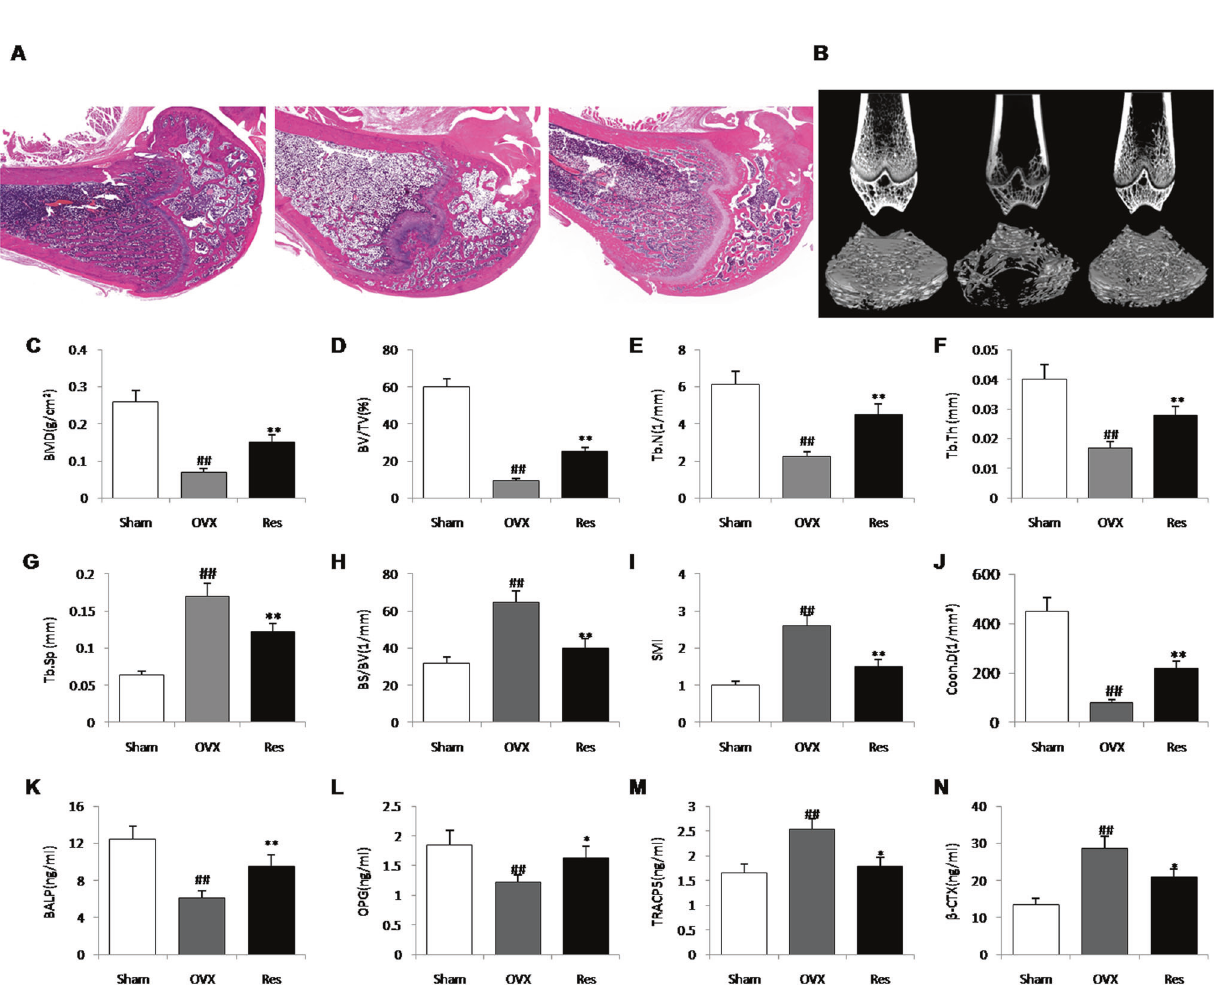
Fig. 5 Protective effect of resveratrol on osteoporosis in ovariectomized rats. A The hematoxylin-eosin staining in distal femur among groups. B The 2D images of sagittal and transverse section. C – J The trabecula parameters of cancellous bone in the proximal tibial metaphysis static parameters: BMD bone mineral density, BV/TV bone volume/tissue volume, Tb.N trabecular number, Tb.Th trabecular thickness, Tb.Sp trabecular separation, BS/BV Bone surface/bone volume, SMI structure model index, and Conn.D connectivity Density. K – N serum bone alkaline phosphatase (BALP), osteoprotegerin (OPG), tartrate resistant acid phosphatase (TRACP-5b), and β -cross-linked c-telopeptide of type I collagen ( β -CTX), n = 5, ## P < 0.01 vs. Sham group; * P < 0.05 vs. OVX group and ** P < 0.01 vs. OVX group. Effects of resveratrol on osteocytes redox balancein in bones (Fig. 5B-J). In addition, serum levels of BALP and osteocalcin, ovariectomized rats bone formation markers, and Tracp 5b and β -CTX, bone resorption To determine whether postmenopausal prevention of resveratrol markers, were detected for assessing the turnover of the bones. is related to a low oxidative stress of osteocytes, the activity and BALP and osteocalcin levels were lower, but β -CTX and TRACP-5b expression of antioxidant enzymes and ROS were examined in levels were obviously higher in the OVX rats than those in the cortical bone of proximal tibias. Our results showed that ROS Sham rats ( P < 0.01). The increased levels of BALP and osteocalcin levels were obviously elevated, whereas superoxide dismutase and decreased levels of Tracp 5b and β -CTX were found in (SOD) activity, catalase (CAT), total antioxidant capacity (tAOC), resveratrol-treated rats compared with those in OVX rats ( P < 0.01) SOD1/SOD2 expression levels were markedly decreased in OVX (Fig. 5K-N). Cell Death Discovery (2023)